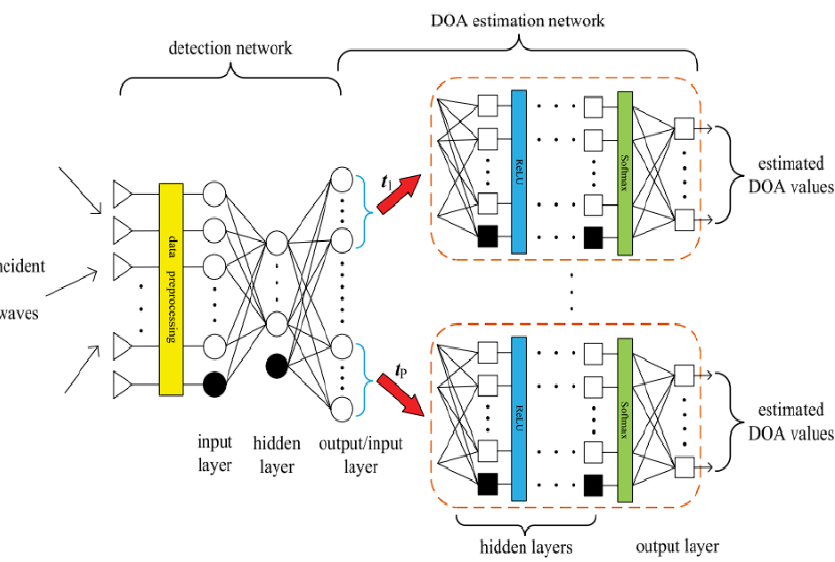
Figure 6. Detection network diagram and DoA (direction of arrival) estimation algorithm using DNN (Deep Neural Network) model [93].